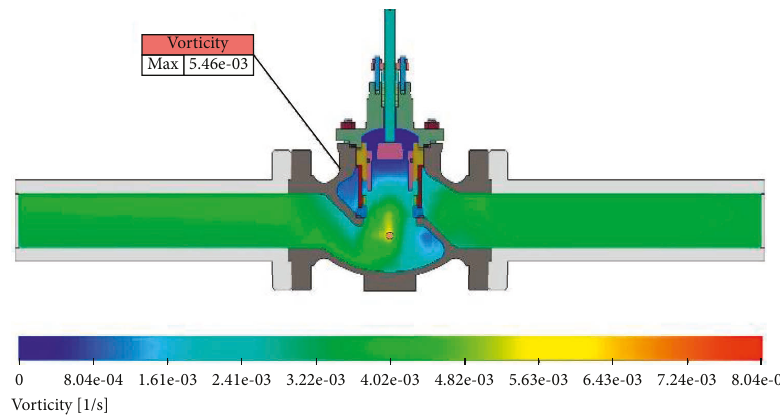
Figure 31: Mach number cloud map for 60%